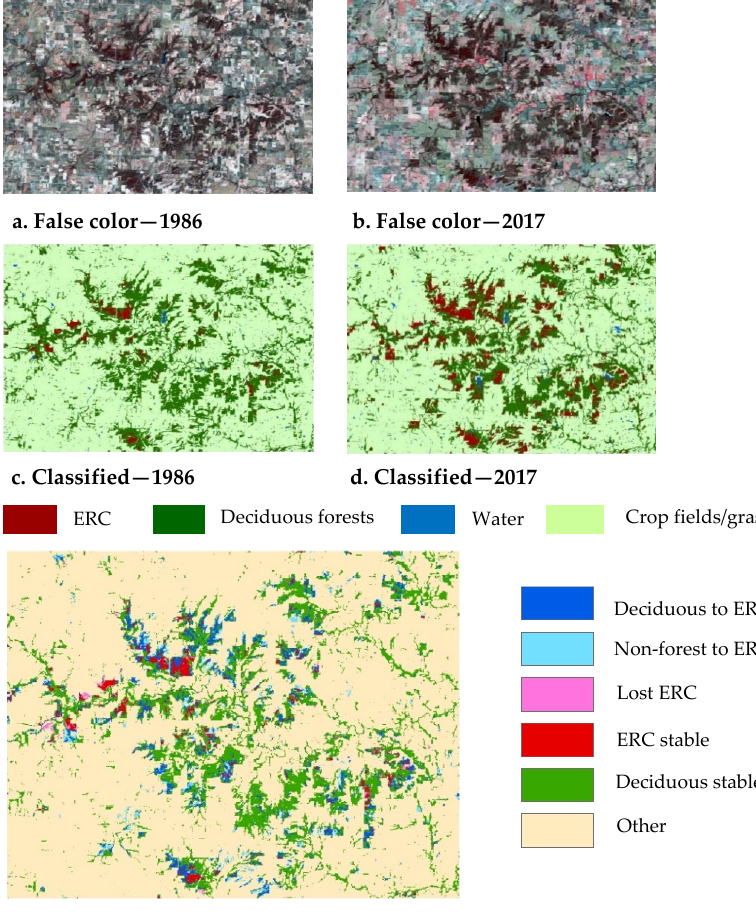
Figure 7. SA3: Bourbon County North. ( a ) 1986 Landsat TM image, ( b ) 2017 Landsat OLI image, ( c ) 1986 classified image, ( d ) 2017 classified image, and ( e ) final change map for Study Area 3 (1986 to 2017).